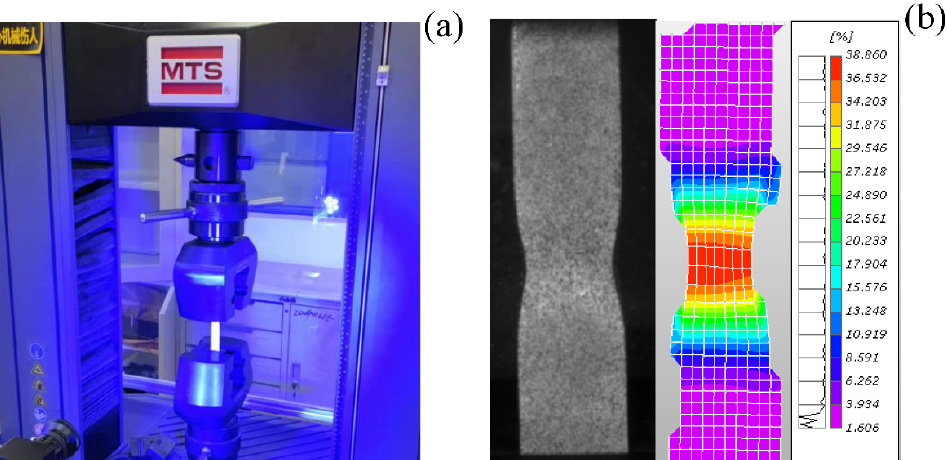
Figure 4. DIC analysis: ( a ) test picture; ( b ) necking and strain distributions before cracking (stand-off = 15 mm, Ti side).